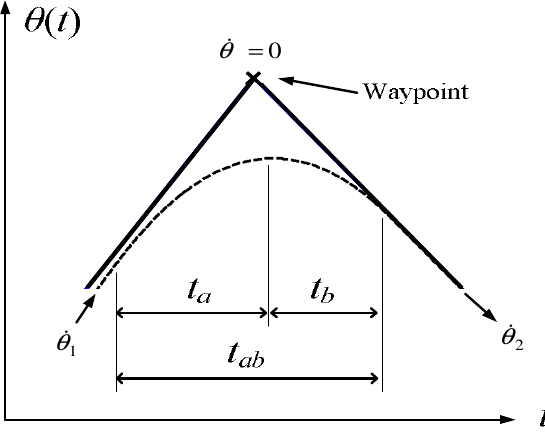
Fig. 2. Trajectory of parabolic